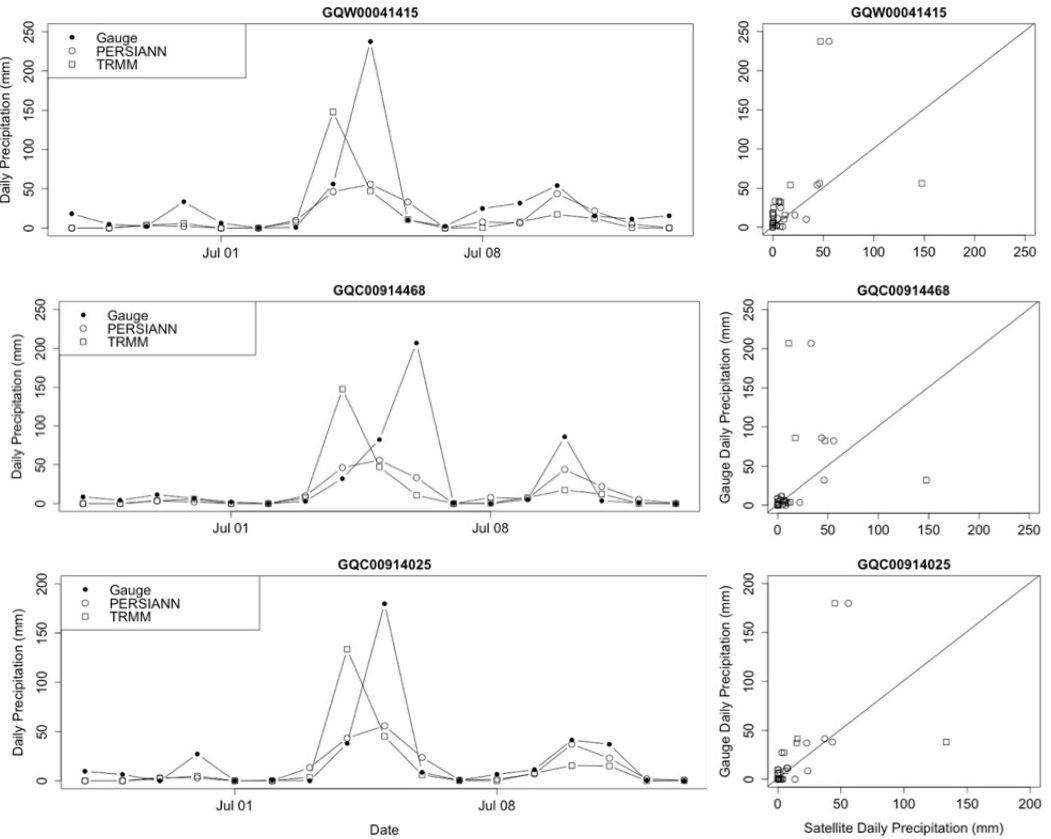
Figure 10. Time series and scatterplots of daily cumulative precipitation for in situ gauges (GQW00041415, GQC00914468, GQC00914025), PERSIANN, and TRMM TMPA during the 2002 Typhoon